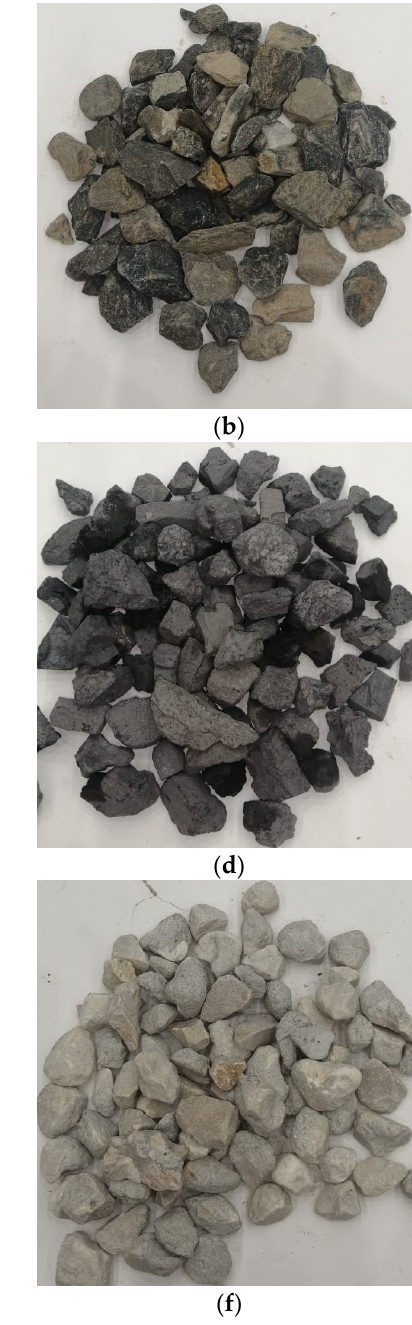
Figure 1. Illustrative pictures of various coarse aggregate types investigated in this study: ( a ) lime- stone-based normal weight aggregate (LS), ( b ) natural quartzite-based normal weight aggregate (MK), ( c ) volcanic scoria-based LWA, ( d ) by-product industrial waste steel slag-based HWA, ( e ) good quality recycled concrete-based normal weight aggregate (RCA-1), and ( f ) poor quality recy- cled concrete-based normal weight aggregate (RCA-2).